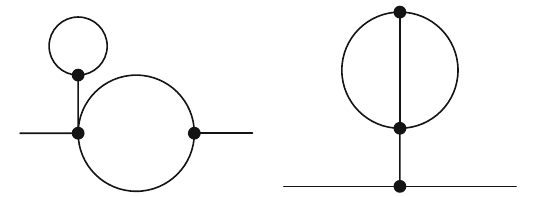
Fig. 1 Examples of one-particle-irreducible diagrams with “internal” propagatorsthatwedonotincludeinourlistoftopologies.Alldiagrams of these classes can be straightforwardly computed from the one- and two-loop self-energies and tadpoles that we include